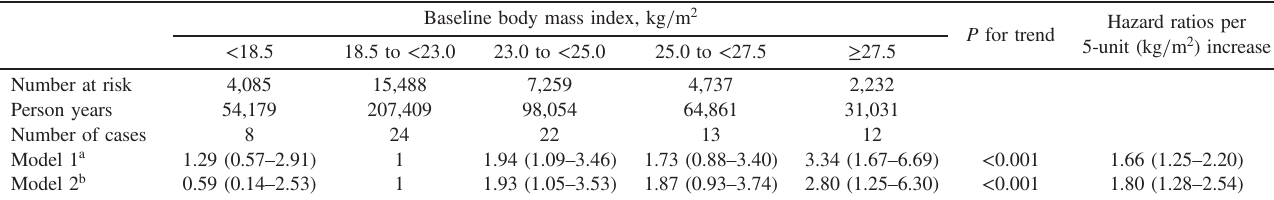
Table 2. Hazard ratios (95% con fi dence intervals) of incident endometrial cancer according to baseline body mass index